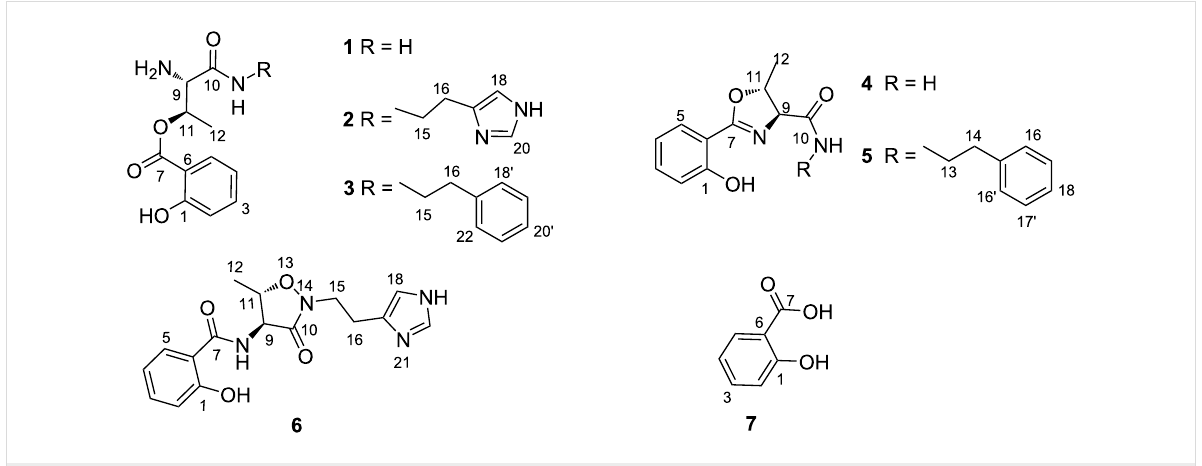
Figure 1: Structures of the new phenolic siderophores 1 – 5 , pseudomonine ( 6 ), and salicylic acid ( 7